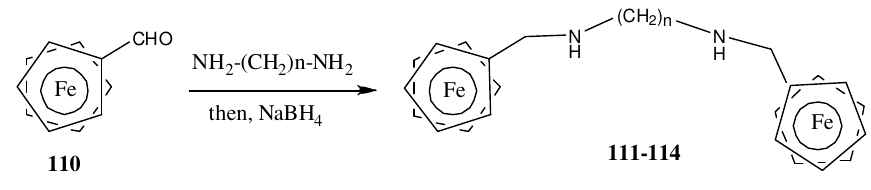
SCHEME 22. Structures of ferrocenyl diamines 111 and 112 .